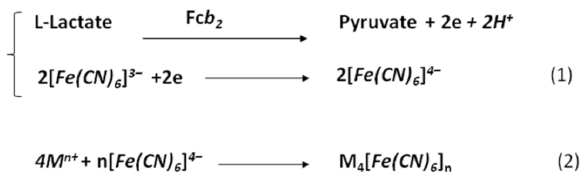
Figure 1. Scheme of green hexacyanoferrate synthesis using flavocytochrome b 2 (Fc b 2 ) in enzymatic ( 1 ) and chemical ( 2 ) reactions;